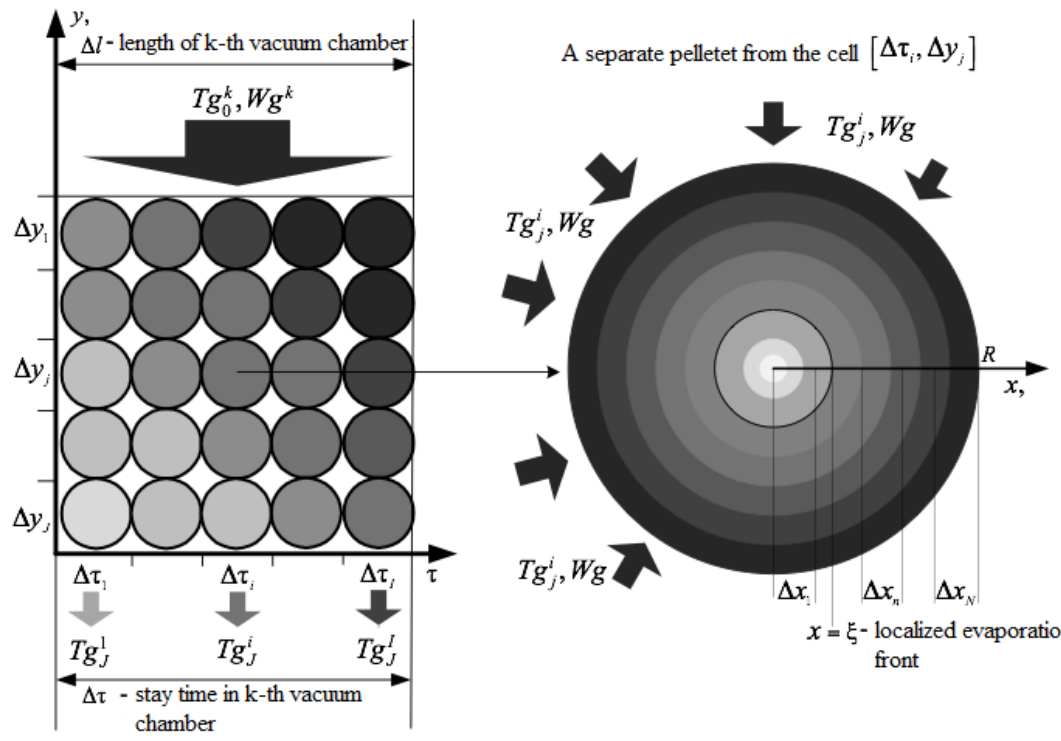
Figure 4. Conventional diagram of a local vacuum chamber, in which for a selected space-time cell (cid:105) (cid:104) ∆ τ ∆ y , a pellet of radius R is considered. , τ i , j i j